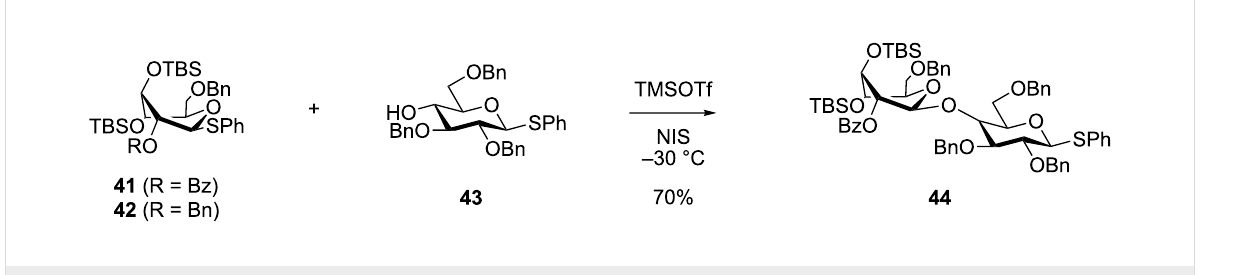
Scheme 8: Superarmed-armed glycosylation with thioglycoside 41